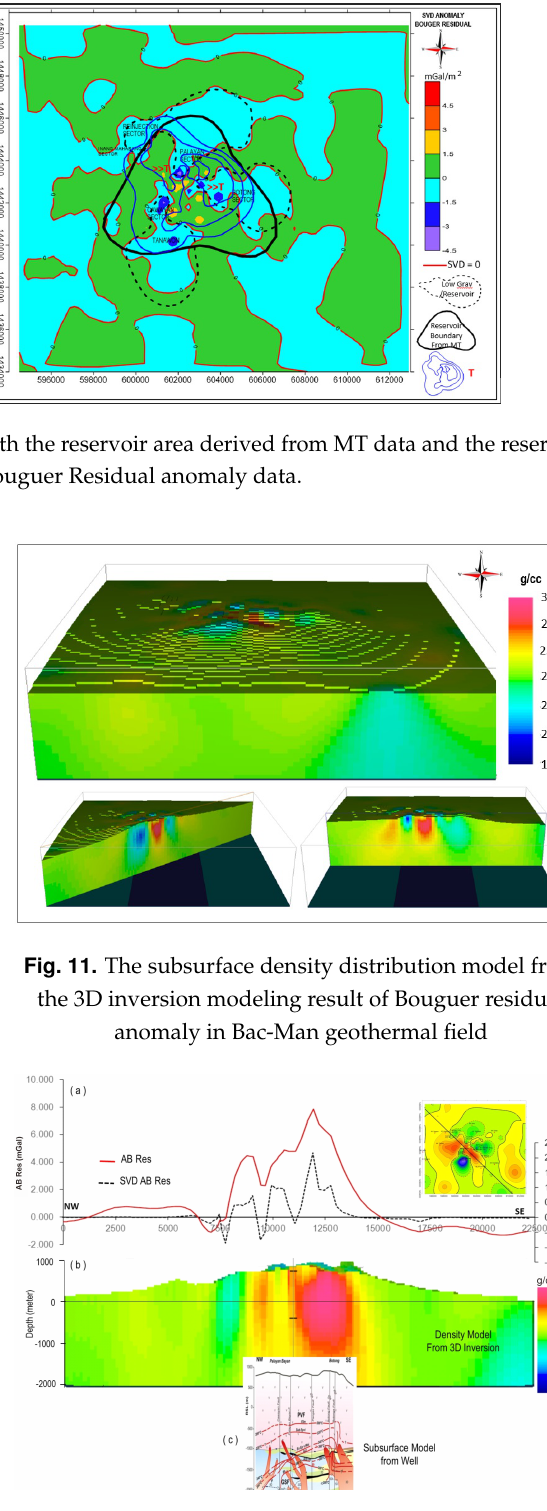
Fig. 12. The cross-section of the density distribution model resulting from the 3D Bouguer residual anomaly inversion correlated with the temperature and intrusion structure cross-sectional model for the NW-SE trajectory